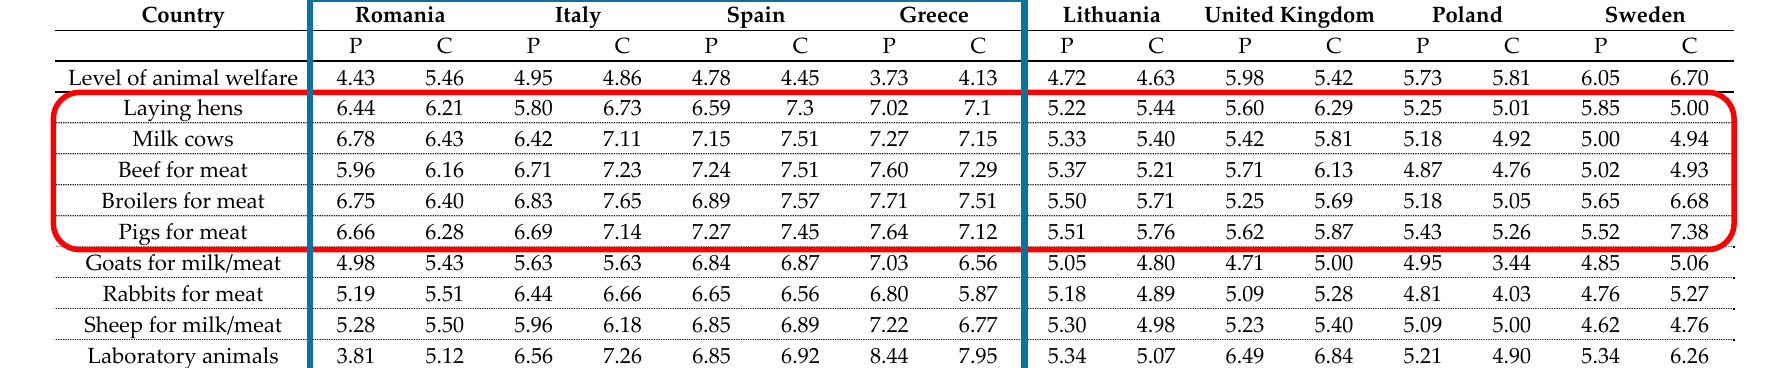
Table 3. Animal welfare concerns by animal species and respondent type.